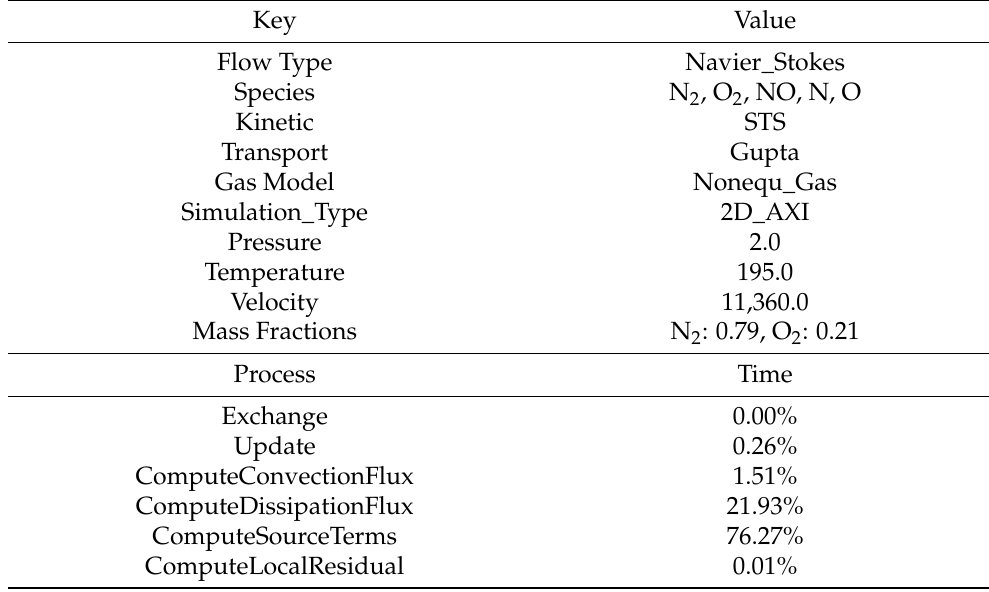
Table 1. Parameter settings and timings of one iteration (0.814 s) for a typical two-dimensional simulation of a hypersonic non-equilibrium viscous reacting flow across a blunt body